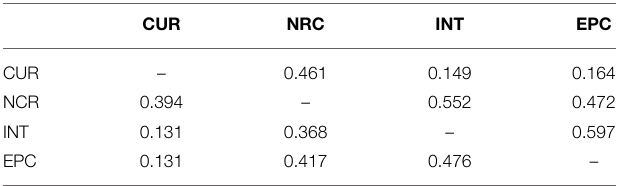
TABLE 6 | Latent factor correlations between the subdimensions in the CCBS.